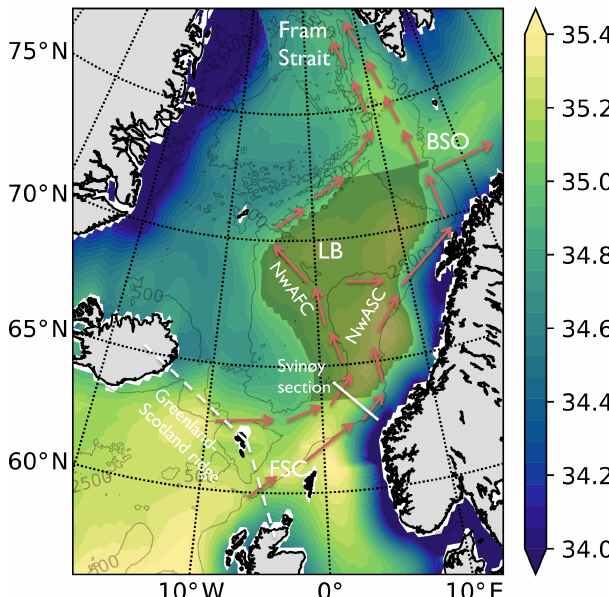
Figure 1. Map of the Nordic Seas with average surface salinity (Zweng et al., 2013) in shading. The general pathways of the Nor- wegian Atlantic Front Current (NwAFC) and the Norwegian At- lantic Slope Current (NwASC) are indicated together with the Lo- foten Basin (LB), Barents Sea Opening (BSO), Fram Strait, parts of the Greenland–Scotland Ridge, the Faroe–Shetland Channel (FSC) and the Svinøy hydrographic section. The darker shaded region is the area enclosed by the mean location of the 35.0 surface salin- ity isohaline between 63.5 and 72.5 ◦ N. This area represents the Atlantic water (AW) area in the current study. Grey contours are bathymetry (Becker et al.,